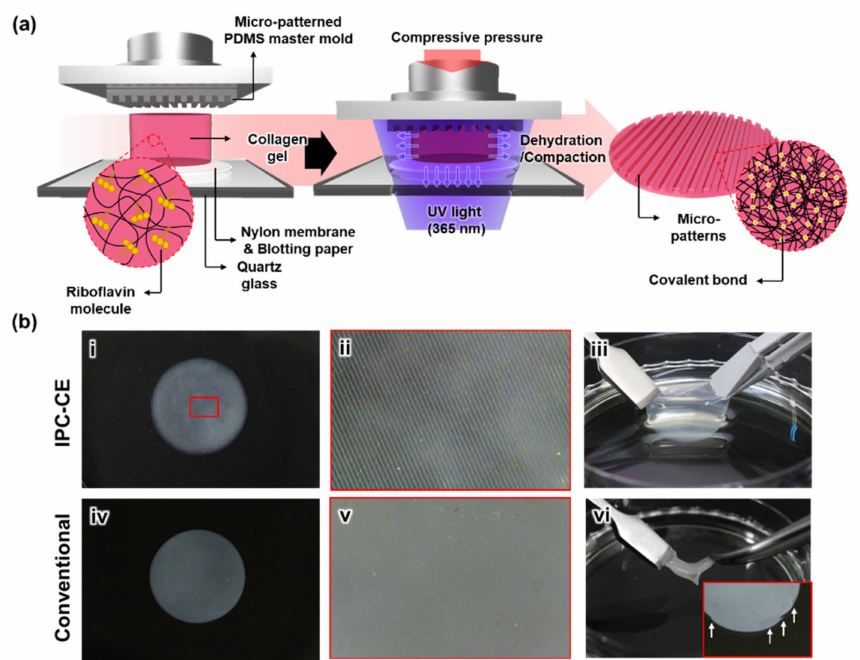
Figure 1. Fabrication of the in situ photochemical crosslinking-assisted collagen embossing (IPC-CE) construct. ( a ) Schematic illustration of the IPC-CE process. ( b ) Photographs of ( i ) the IPC-CE construct and ( ii ) its magnified surface. ( iii ) Manual handling of the IPC-CE construct. ( iv ) The conventional construct and ( v ) its magnified surface. ( vi ) Structural weakness of conventional construct for manual handling. White arrows in inset indicated damages induced by manual